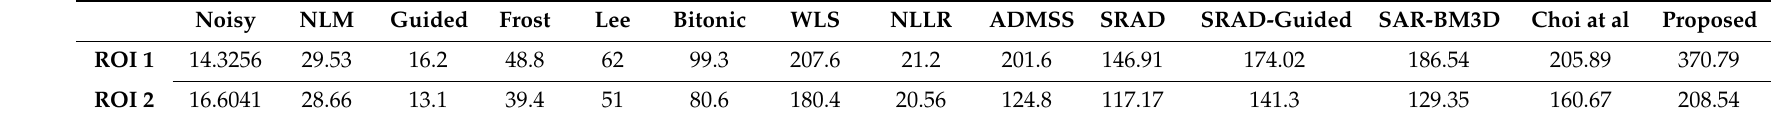
Table 7. Equivalent number of looks (ENL) results for SAR image 1.